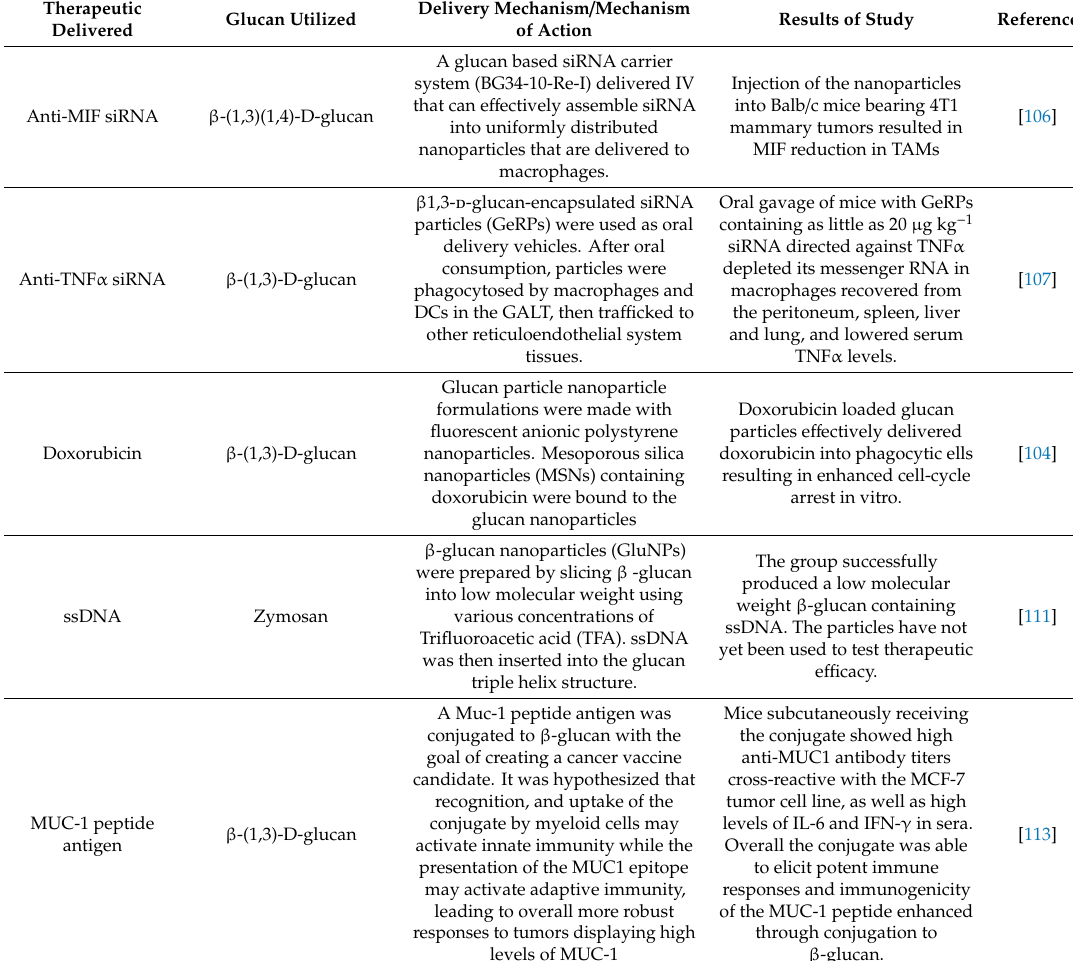
Table 1. The use of β -glucan to deliver cancer